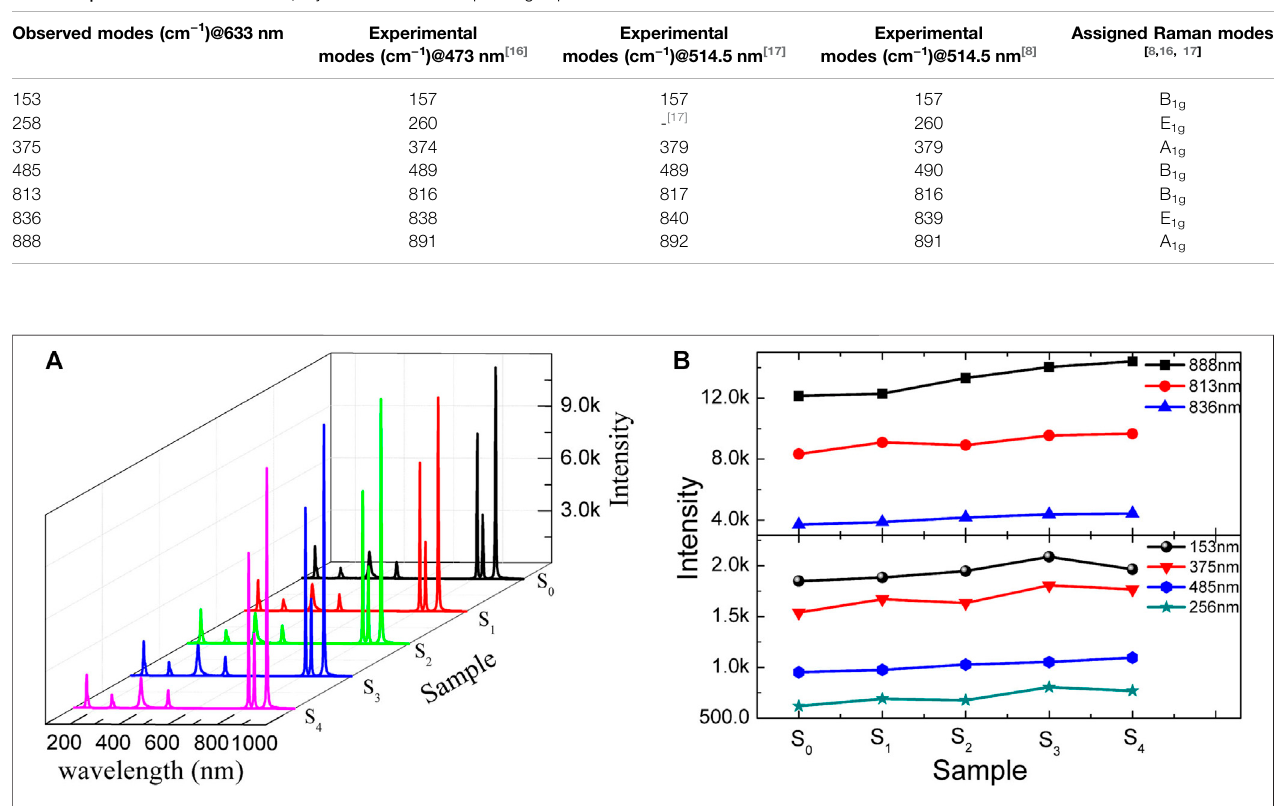
FIGURE3|(A) Confocalmicro-RamanspectrainYb:YVO 4 crystaland waveguideareas inS 0 ,S 1 ,S 2 , S 3 ,and S 4 ; (B) Intensityoftheconfocalmicro-Ramanpeaks in Yb:YVO 4 crystal and waveguide areas in S 0 , S 1 , S 2 , S 3 , and S 4